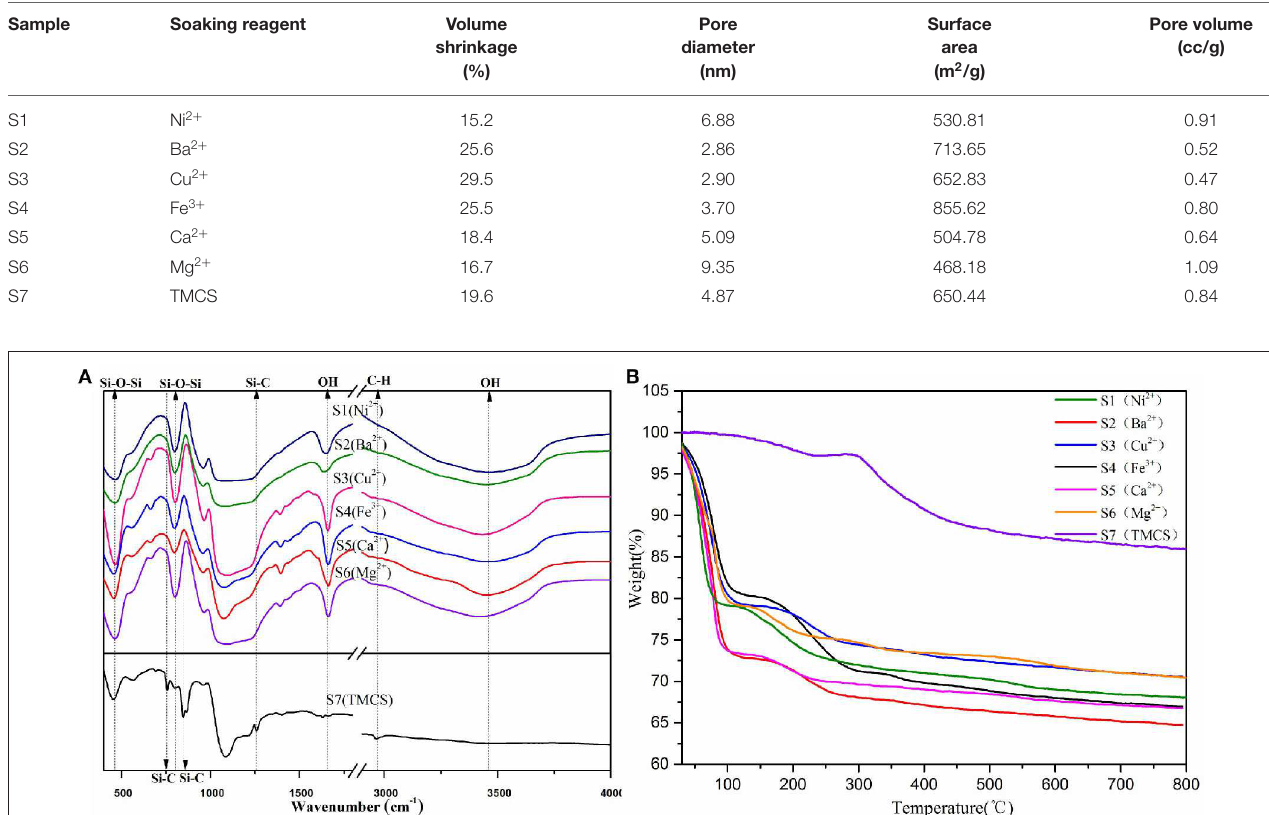
TABLE 1 | Pore properties of TEOS-originated ambient pressure–dried SAs soaked with various reagents. Sample Soaking reagent